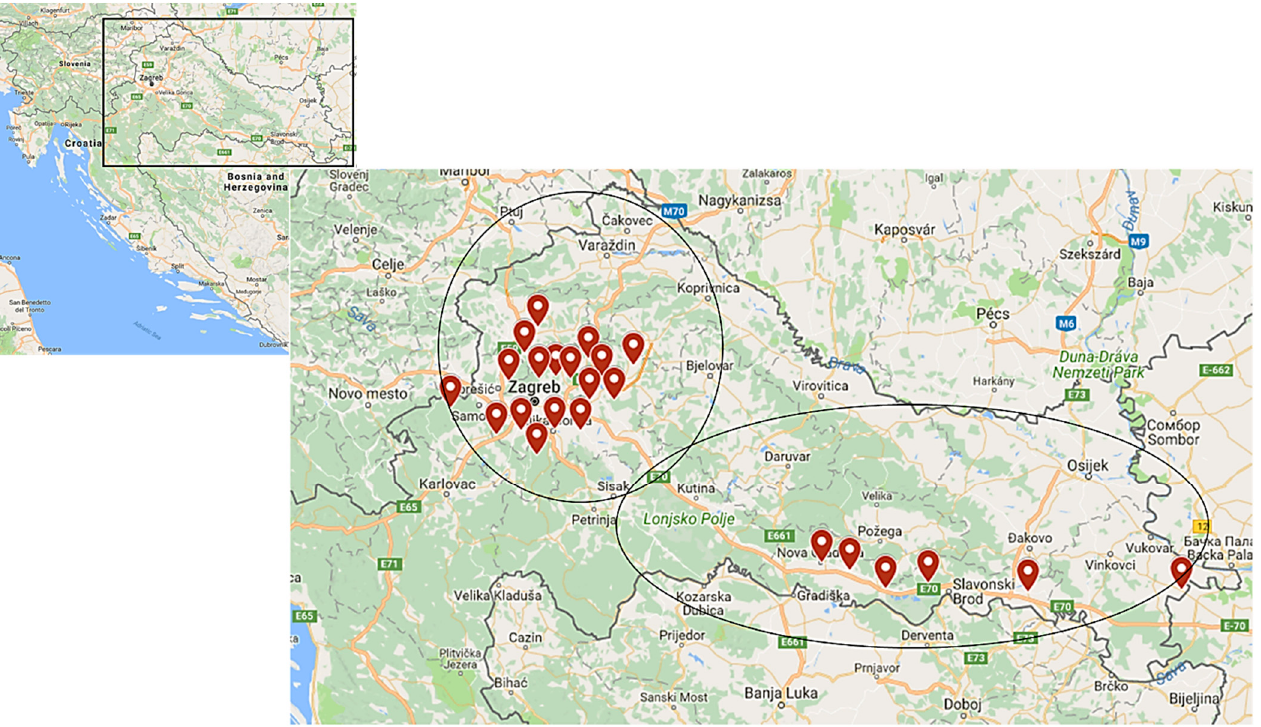
Figure 2. Geographic distribution of LCMV seropositive